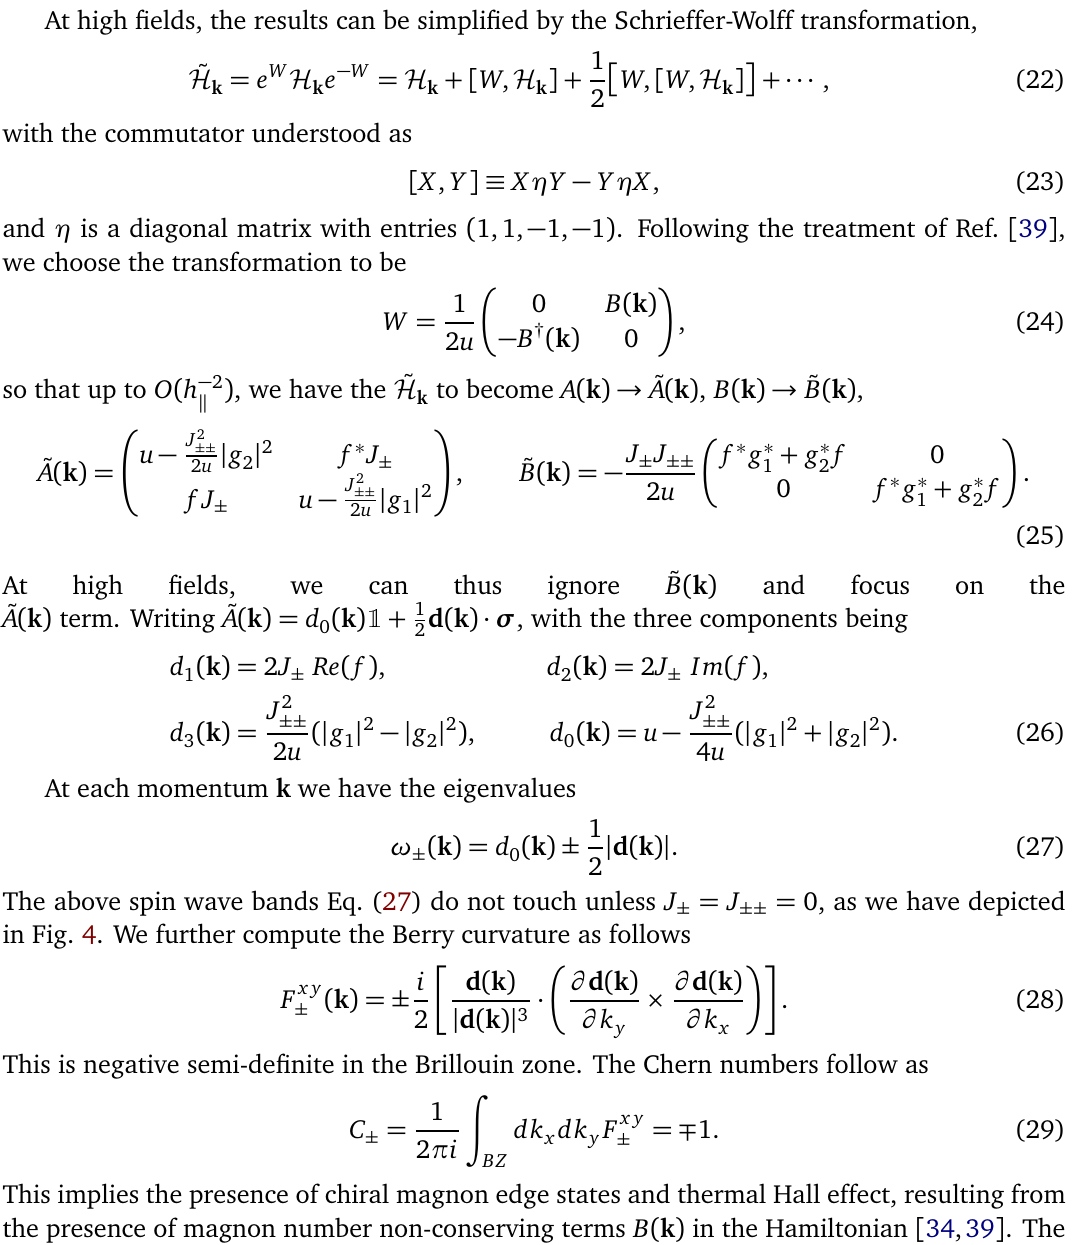
Figure 4: (Color online.) The two spin wave bands ω ± when a strong field in the z -direction is applied. The parameters are chosen as = 1; J = 0.9; J = 1; J = 0.3; u = J ± ±± ± z zz